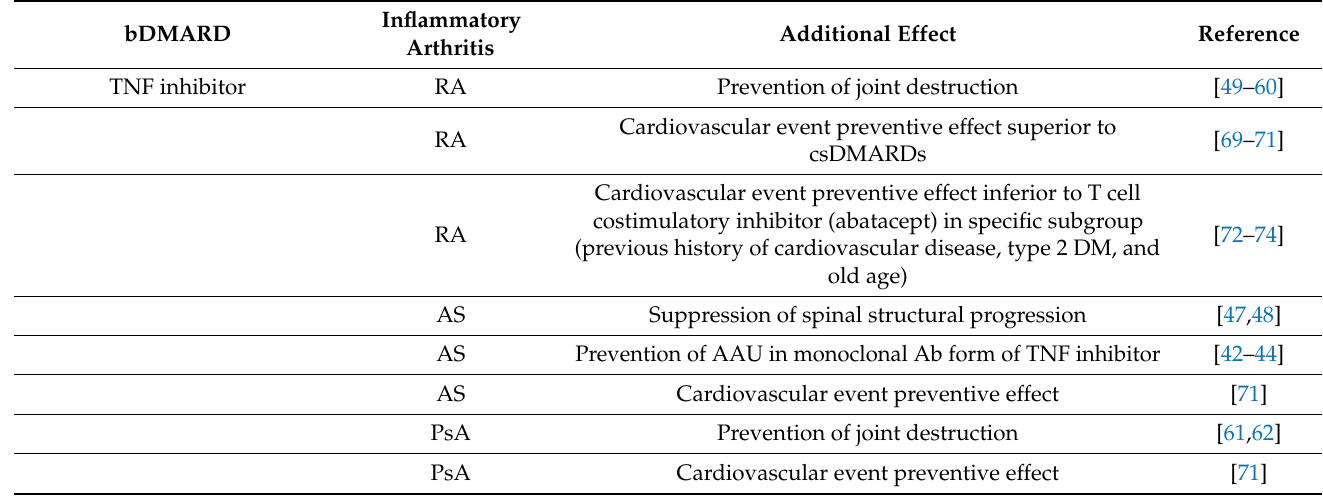
Table 2. Additional effects of bDMARDs in patients with inflammatory arthritis over anti- arthritic